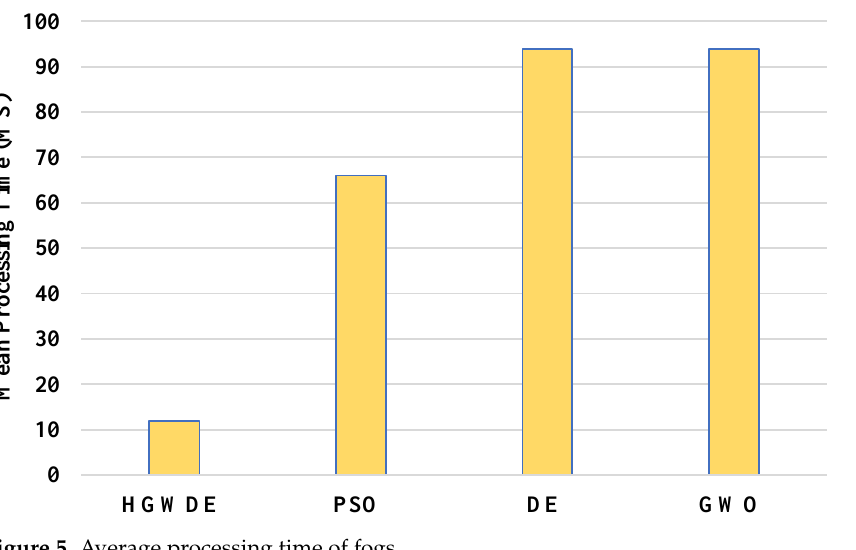
Figure 5. Average processing time of fogs. Table 4. Overview of processing time for each algorithm.